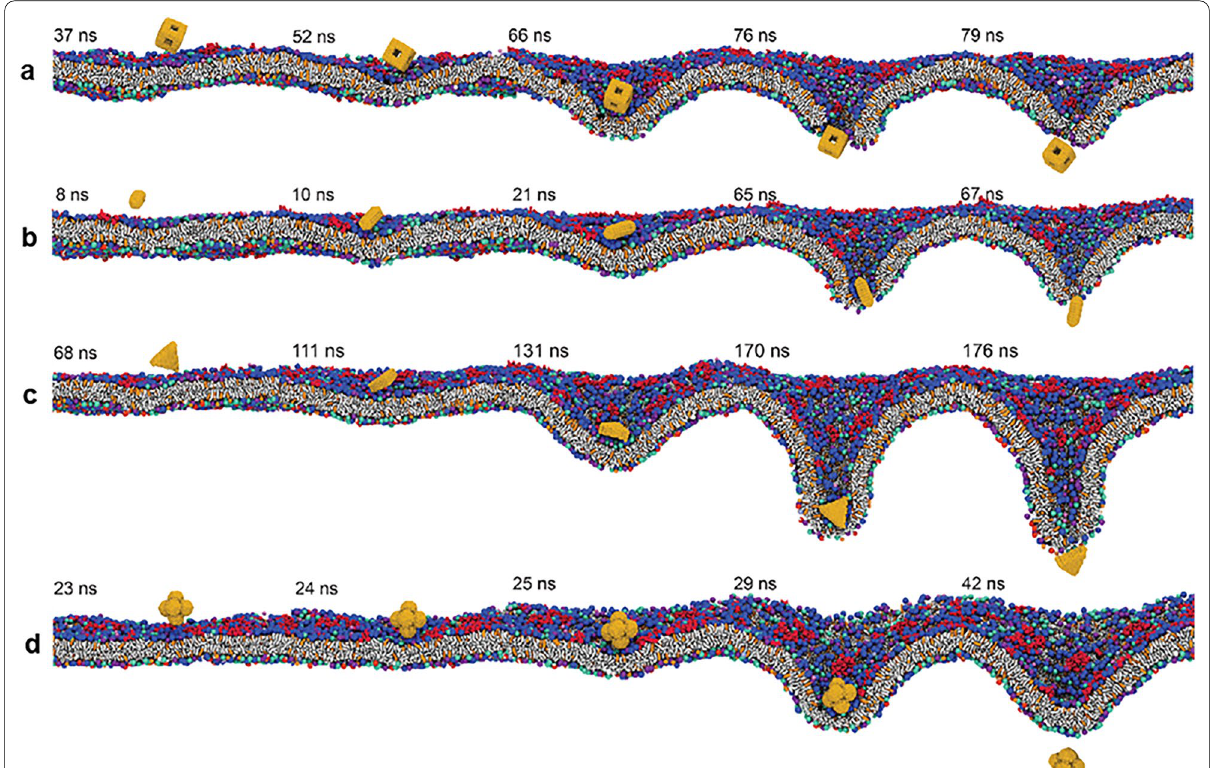
Fig. 2 Snapshots of different shapes of AuNPs approaching the plasma membrane and undergoing reorientation during translocation. a Nanocage, b nanorod, c nanoplate, and d nanohexapod, each with the longest characteristic length of 2 nm. Water molecules both in the outer and inner cell are not shown for clarity. Reprinted with permission from [37], Copyright 2019, American Chemical